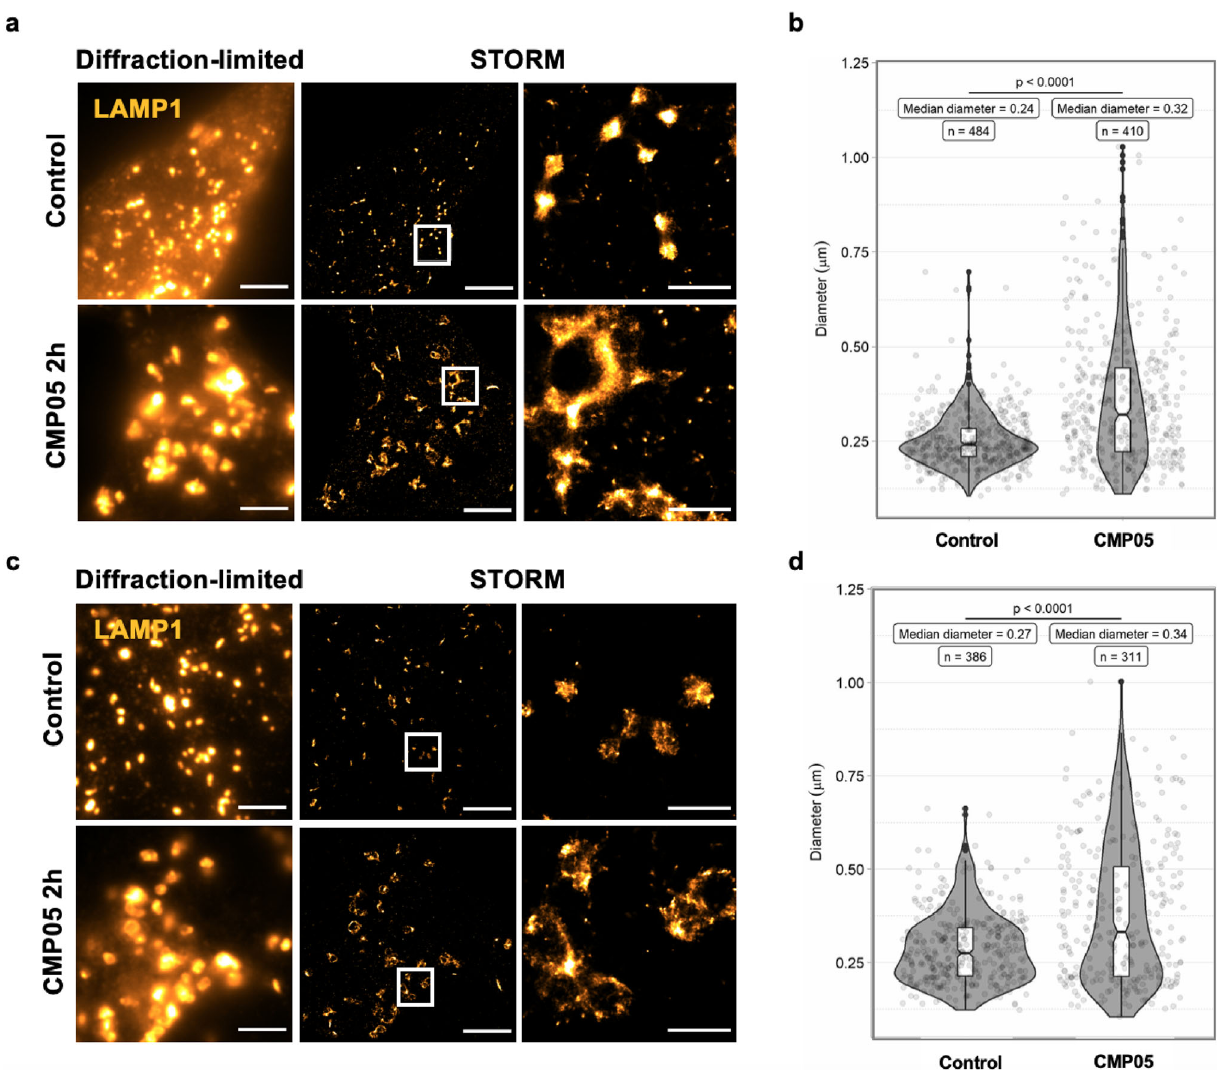
Fig. 4 Visualization of lysosomes in control and CMP05-treated HeLa and HuH7 cells. a Diffraction-limited and STORM imaging of LAMP1 immunostaining in HeLa cells after 2 h, 5 µ M CMP05 treatment. Scale bars in full-size images are 5 μ m and in the enlarged area 1 μ m. Enlarged visual fi elds are identi fi ed by white boxes. b Quanti fi cation of the lysosome sizes in STORM images of the HeLa cells using ilastik software. Smoothed curves show the kernel density estimate for each population, overlaid with boxplot of quartiles and the underlying data. c Diffraction-limited and STORM imaging of LAMP1 immunostaining in HuH7 cells after 2 h, 2.5 µ M CMP05 treatment. Scale bars in full-size images 5 μ m and in the zoomed area are 1 μ m. d Quanti fi cation of the lysosomes sizes in STORM images of the HuH7 cells using ilastik software. Smoothed curves show the kernel density estimate for each population, overlaid with boxplot of quartiles and the underlying